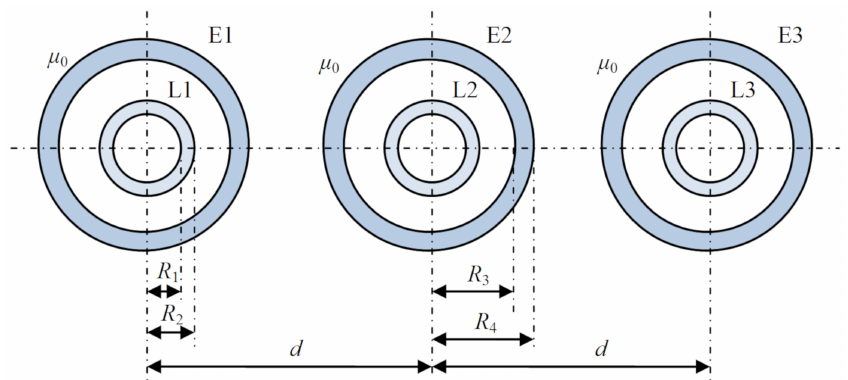
Figure 1. Three-phase high-current busduct with isolated